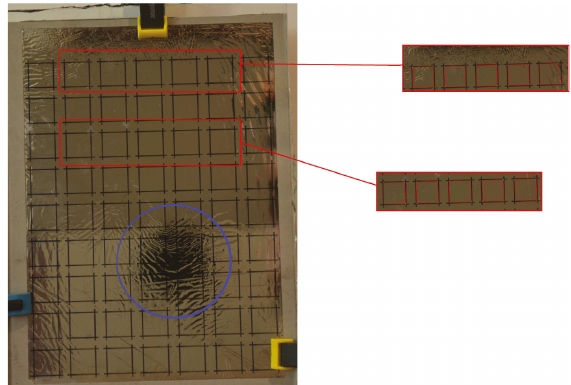
Figure 17: Kapton foil test. Denote the black re fl ection (marked by a blue circle) at the lower part — such re fl ection issues can be solved with a controlled lighting. Yet, any real implementation should be able to overcome re fl ection problems by detecting them and addressing them as outliers.